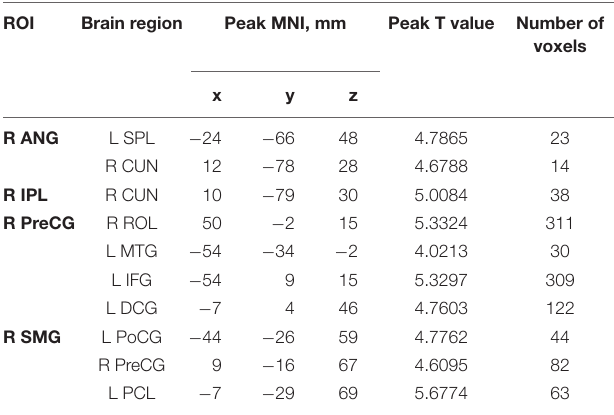
TABLE 4 | The peak MNI coordinates and intensity of brain clusters with significant intergroup differences in voxel-wise FC values ( P < 0.05, corrected for GRF). ROI Brain region Peak MNI, mm Peak T value Number of